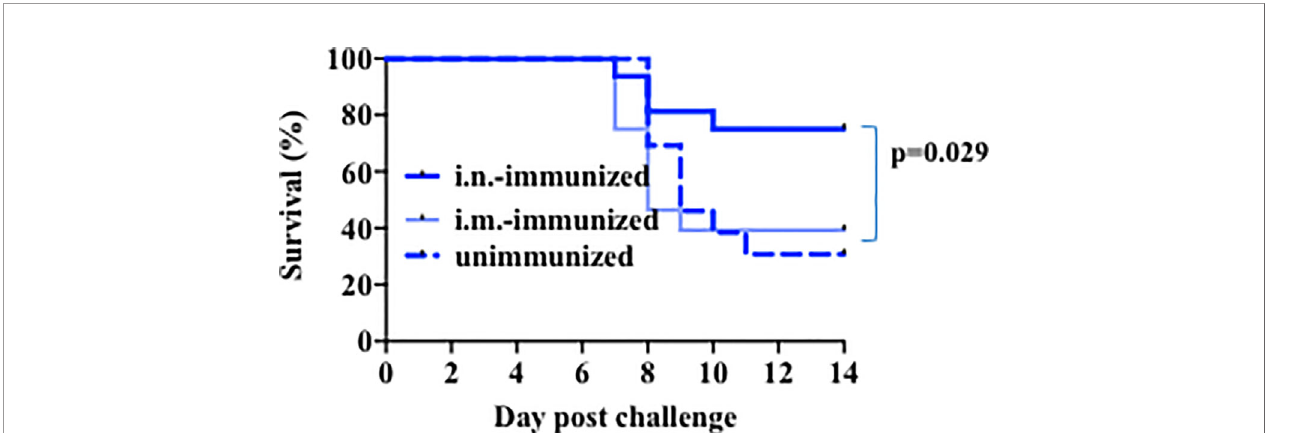
FIGURE 2 | Intranasal immunization with heat inactivated virus protects infant mice against lethal challenge. Mice aged 14 – 17 days of life were immunized intranasally (Bold Dk blue, n=16) or intramuscularly (Lt blue, n=28) with 5 × 10 5 EIU heat inactivated PR8 virus, or left unimmunized (dotted lines, n=13). Three weeks later, all mice received a lethal dose of live virus. Y axis: Survival. Mantel-Cox (log-rank) analysis was used to compare unimmunized to i.n.-immunized mice. Signi fi cance was set at p<0.05. Analysis is of total data obtained from 8 independent cohorts of mice receiving immunization and or